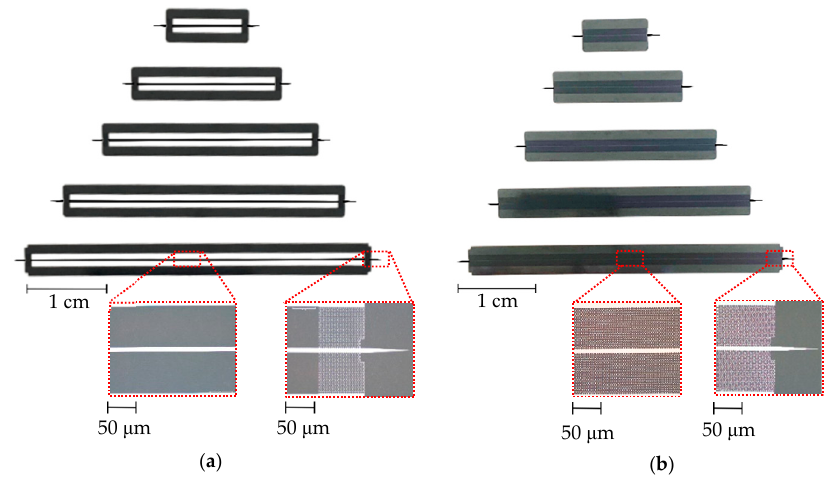
Figure 5. Fabricated waveguide samples with micrographs as inset: ( a ) Unclad waveguides; ( b ) EM waveguides.